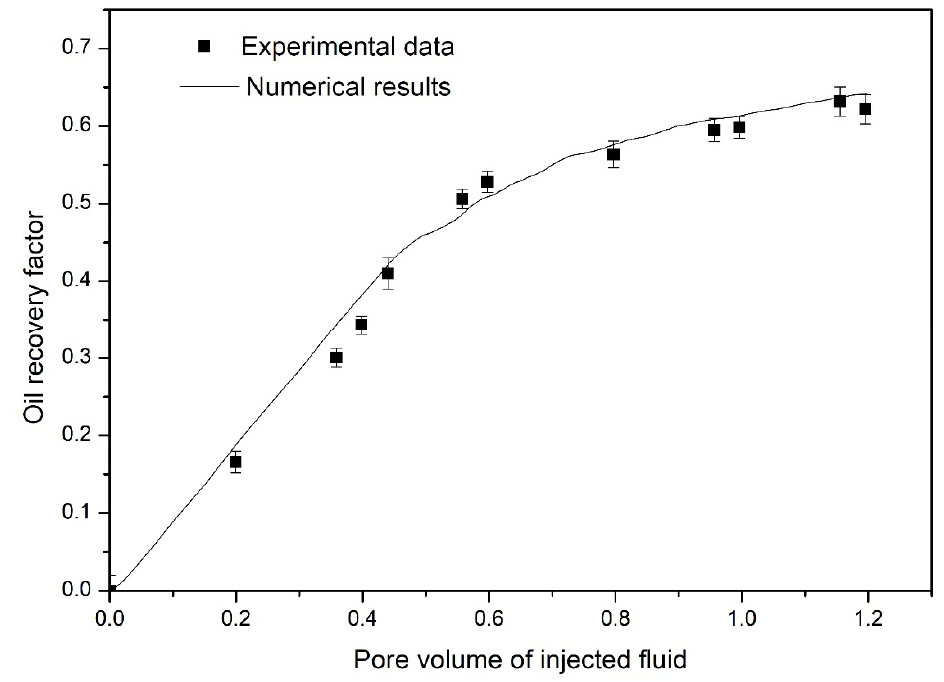
Figure 5. Comparison of numerical results with experimental data from Betancur et al. [62]. Reproduced with permission from Céspedes-Zuluaga S, Computational fluid dynamics as a tool for the design of micromodels for the evaluation of surfactant injection in enhanced oil recovery processes; published by Universidad Nacional de Colombia, 2020.